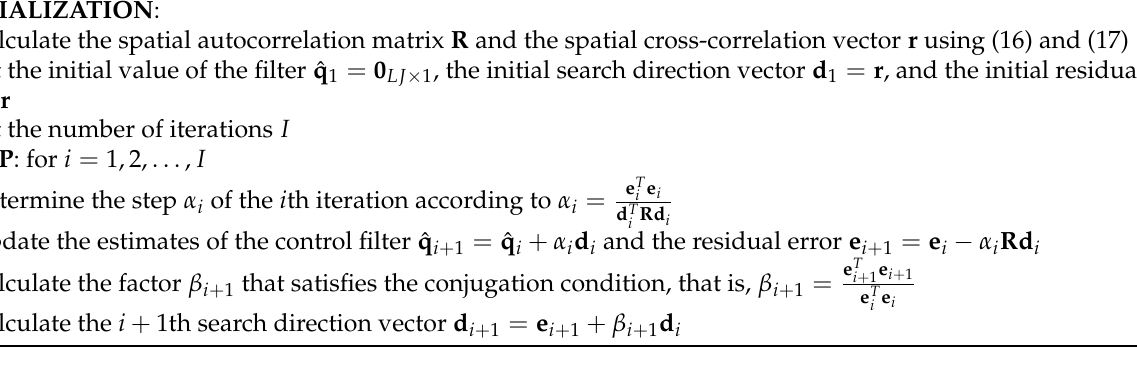
Table 1. Conjugate gradient algorithm for implementing the proposed time-domain sound field reproduction system. INITIALIZATION